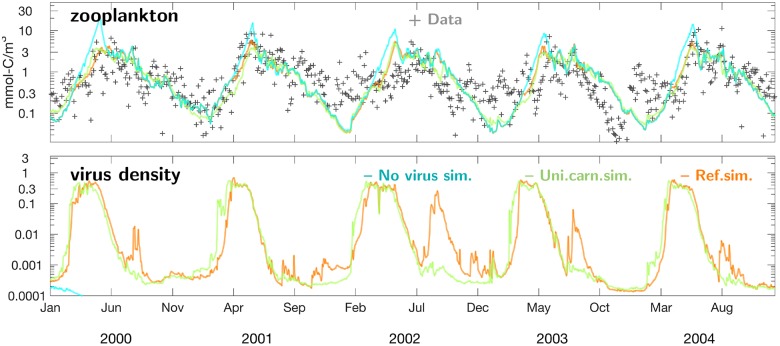
Factors of phytoplankton mortality.Top: Five annual cycles of simulated zooplankton biomass (lines) versus mesozooplankton biomass calculated using count measurements (black crosses) at Helgoland. Bottom: Simulated dynamics of intracellular virus density. Again results of three simulations are shown: reference run (orange), the run with spatially uniform carnivory (green), and the one lacking the virus compartment (cyan).